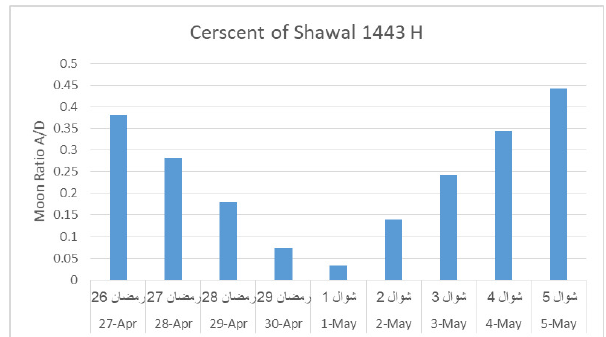
Figure 10. The model’s crescent visibility of Shawal 1443 H.